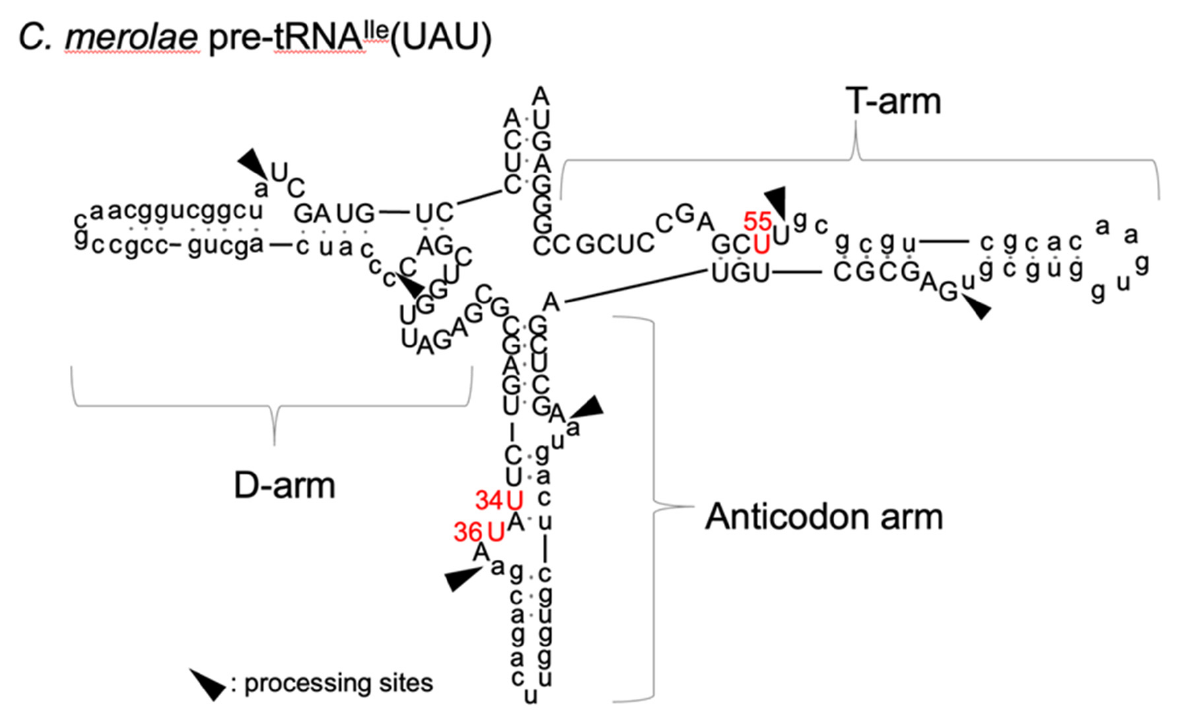
Figure 1. An inferred secondary structure of pre-tRNA Ile (UAU) of C. merolae . Three introns, shown in lowercase letters, interrupt D-arm, anticodon arm, and T-arm of the mature tRNA Ile (UAU) nucleotide, shown in uppercase letters. In yeast tRNA Ile (UAU), U34/U36 and U55 are pseudouridylated by yeast Pus1 and Pus4, respectively. U34, U36, and U55, which may be pseudouridylated by cmPus1 and cmPus4, are indicated in red.